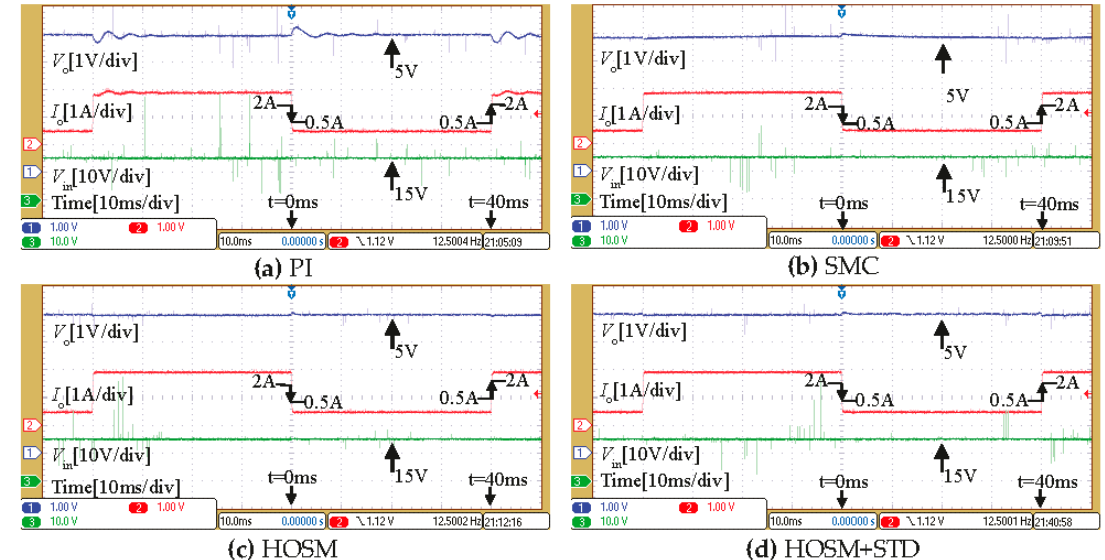
Figure 8. Experimental results of output voltage for buck converter under step load resistance disturbance ( R = 2.5 Ω → 10 Ω at t = 0 ms and R = 10 Ω → 2.5 Ω at t = 40 ms, V in = 15 V) with different controllers: Blue Channel 1 ( top line) output voltage V o (1 V/div), Red Channel 2 ( middle line) load current I o (1 A/div), Green Channel 3 ( bottom line) input voltage V in (10 V/div).